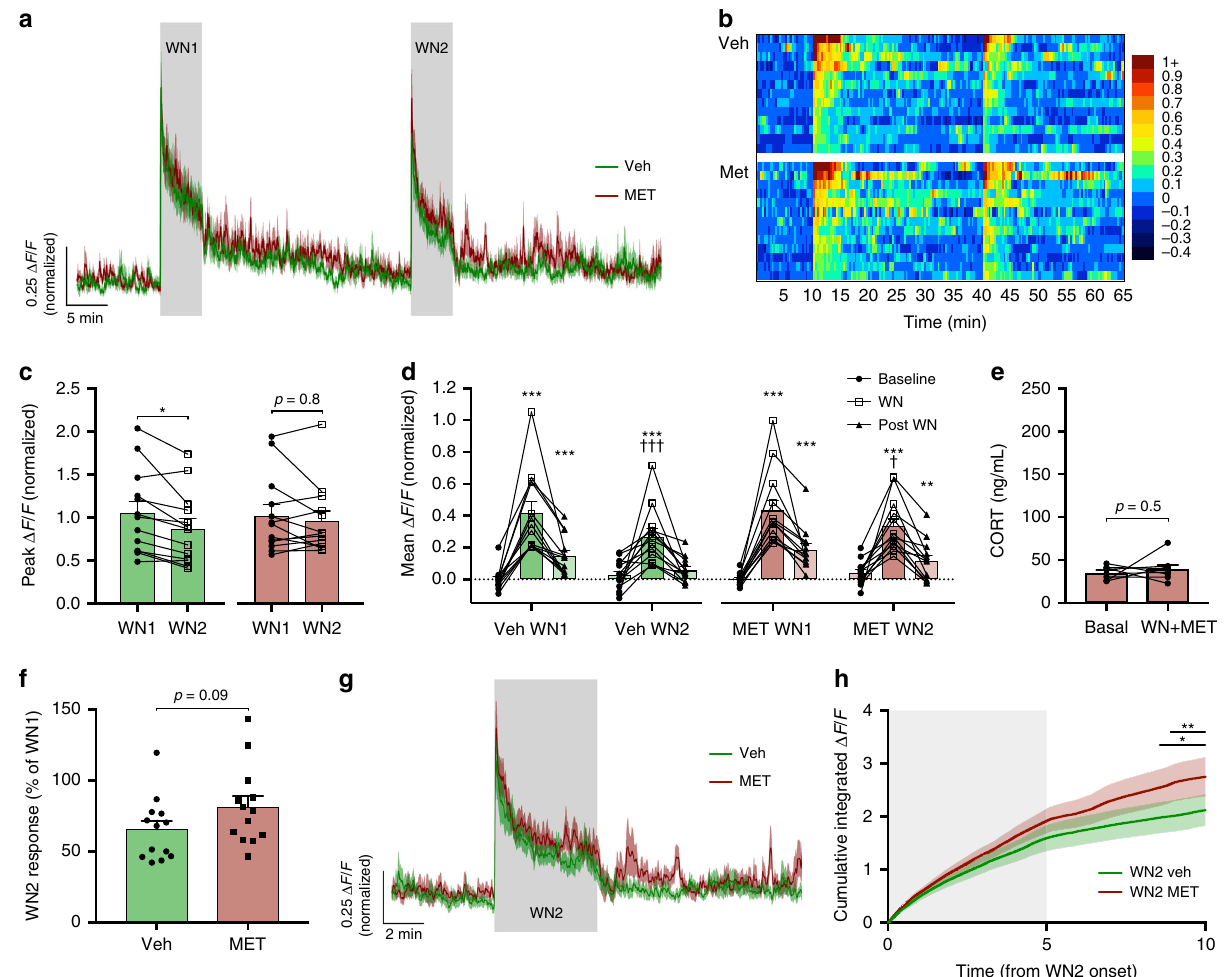
Fig. 2 CRH neuron shut-off and adaptation occur regardless of fast CORT feedback. a Mean photometry signals of CRH neuron activity induced by two sequential WN stressors 30 min apart from vehicle and metyrapone-treated mice. b Heatmap of mean CRH neuron activity from all individual mice in 20 s bins. c Peak Δ F / F at WN onset; RM two-way ANOVA, * p < 0.05 vs. WN1, Holm – Sidak; ANOVA interaction p = 0.14, ANOVA main effect of group p = 0.86. d Average Δ F / F across 5 min of CRH neuron activity before, during, and after each WN; n = 13 per group, RM two-way ANOVA, * p < 0.05 vs. baseline, † p < 0.05 vs. respective WN1 timepoint, Holm – Sidak; ANOVA interaction p = 0.90, ANOVA main effect of group p = 0.38. e CORT levels before and after WN stress following metyrapone treatment; n = 8, paired t test. f Percentages of CRH neuron activity during WN2 relative to WN1; Veh vs. MET, Mann – Whitney test. g Averaged photometry recordings of CRH neuron activity from all vehicle and metyrapone-treated mice showing the response to WN2. h Cumulative integrated Δ F / F from the time of WN2 onset; RM two-way ANOVA, * p < 0.05 Veh vs. MET, Holm – Sidak; ANOVA interaction p < 0.001, ANOVA main effect of group p = 0.09. Lines indicate points at which statistical signi fi cance was reached and its duration. Gray shaded area indicates duration of WN. All data are presented as mean ± SEM, */ † p < 0.05, **/ †† p < 0.01, ***/ ††† p <